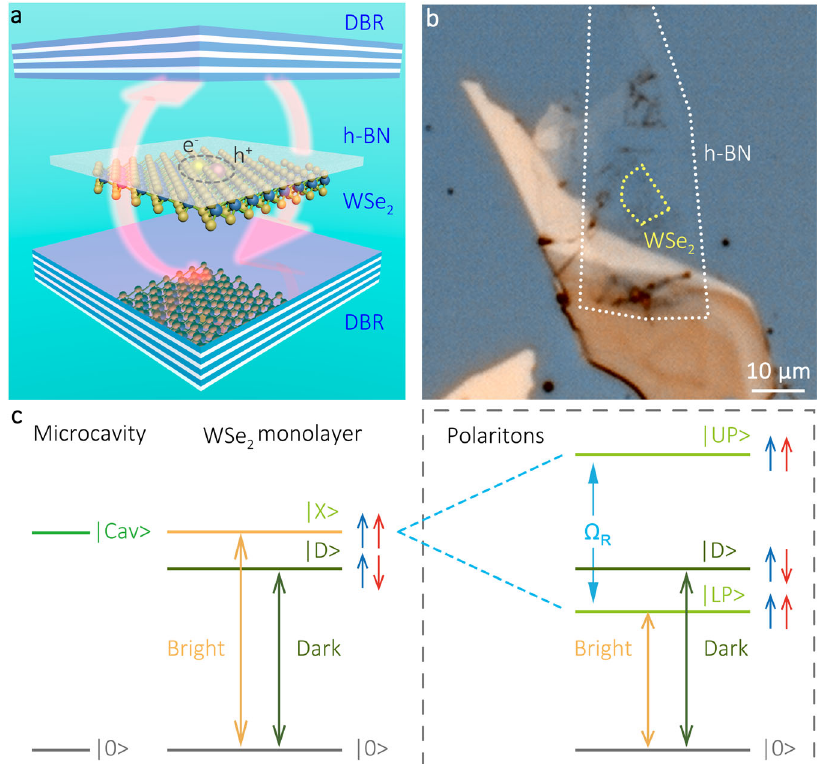
Fig. 1 Sample structure and brightening mechanism. a Schematic illustration of sample structure with a WSe 2 monolayer, capped with h-BN, and embedded between two dielectric DBRs. Two arrows represent the Rabi oscillation between excitons and microcavity photons. b Optical microscopic image of the sample. The WSe 2 monolayer and h-BN boundaries are indicated with yellow and white dashed lines, respectively. c Scheme of WSe 2 ground state brightening via strong coupling. In pristine WSe 2 monolayers, the optically dark exciton D j i (brown line) is the lowest transition at the K -point, which lies ~40 meV below the bright exciton X j i (orange line). Exciton-polaritons are formed when optically bright excitons strongly couple to microcavity photons, the corresponding energy diagram is enclosed in a dashed box. The energy level of the resulting lower polaritons LP j i can be located below the dark exciton state D j i , as long as the Rabi splitting Ω R is suf fi ciently large. The lower polariton branch, which inherits the spin character from the bright exciton, becomes the ground state of the coherently dressed system. Thus, the band ordering is reversed, and the intrinsically dark 2D semiconductor is effectively brightened via the strong coupling with microcavity photons.